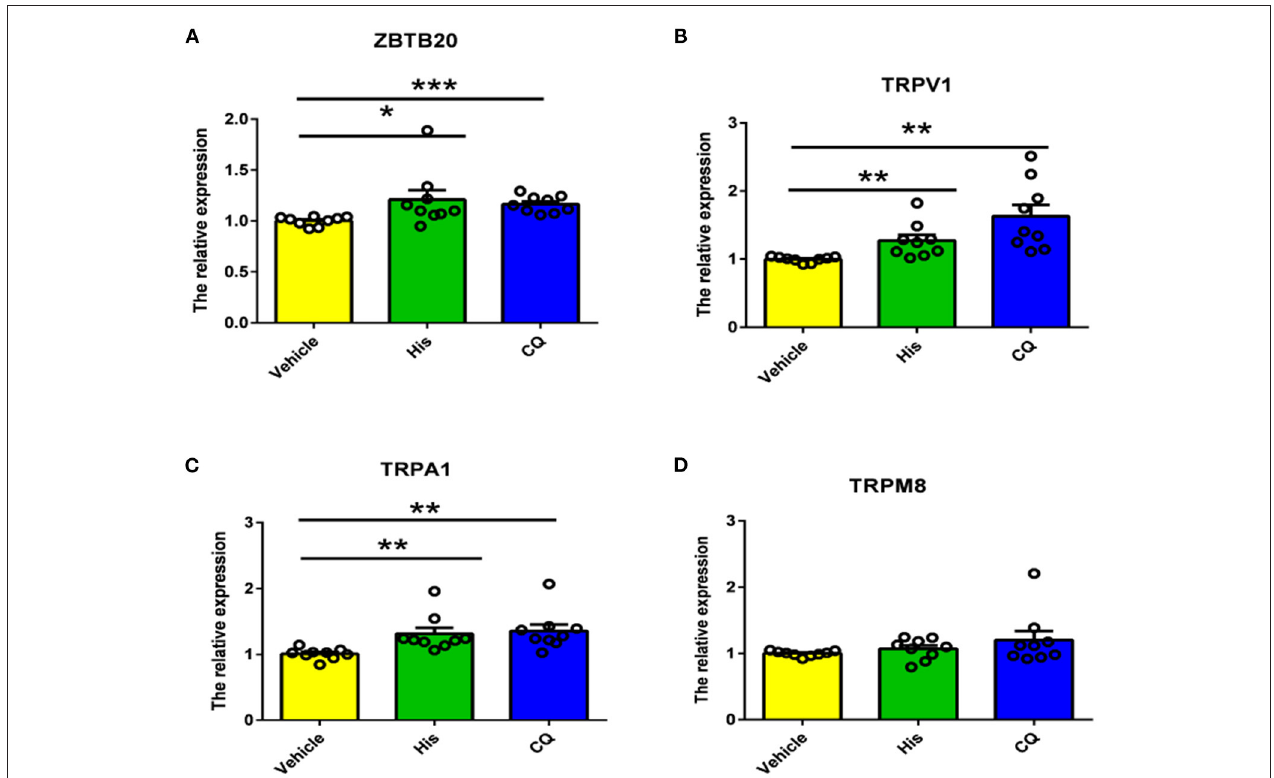
FIGURE 6 | Histamine and CQ increased the mRNA expression of ZBTB20, TRPV1, and TRPA1 but not TRPM8 in the trigeminal ganglia. (A) The mRNA expression of ZBTB20 in the TG was increased after histamine and CQ injection into the cheek ( t -test, * p < 0.05, *** p < 0.001 vs. the vehicle group). (B) The mRNA expression of TRPV1 in the TG was increased after histamine and CQ injection into the cheek ( t -test, ** p < 0.01 vs. the vehicle group). (C) The mRNA expression of TRPA1 in the TG was increased after histamine and CQ injection into the cheek ( t -test, ** p < 0.01 vs. the vehicle group). (D) The mRNA expression of TRPM8 in the TG was not increased after histamine and CQ injection into the cheek ( t -test, p > 0.05 vs. the vehicle group). N = 9 for each group.